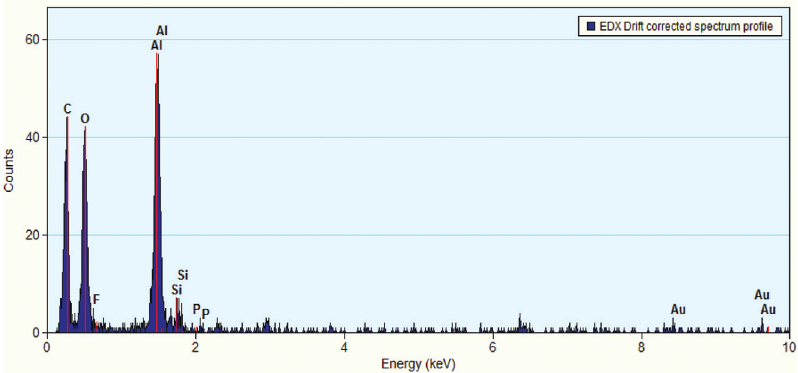
Figure 5: EDX spectrum measured from the interface between diamond coating and substrate.